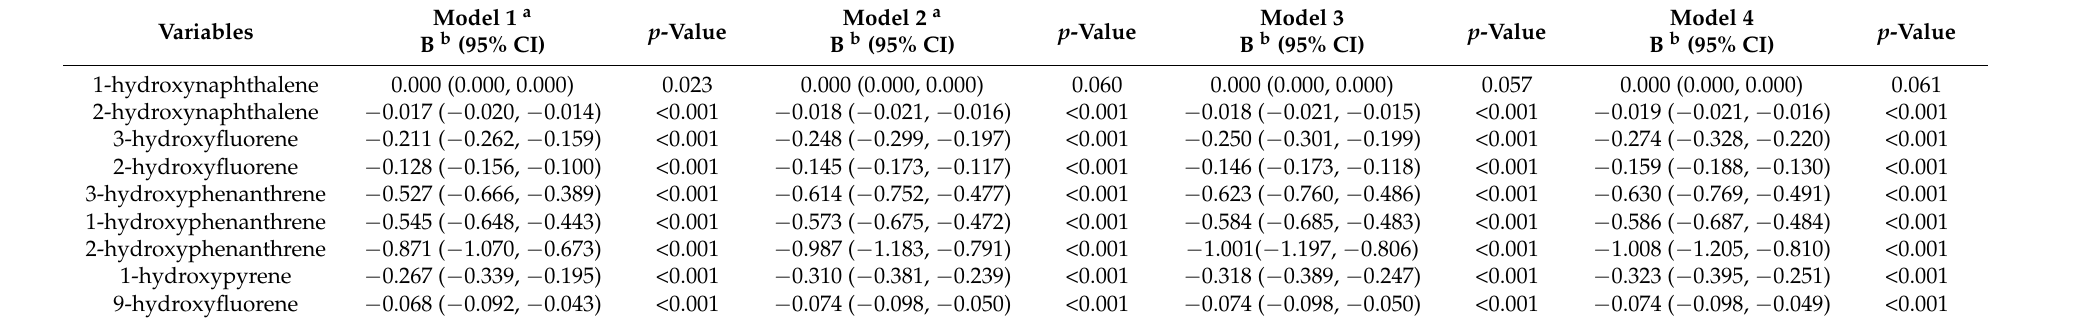
Table 2. Associations between the PAH metabolites and urine flow rate.